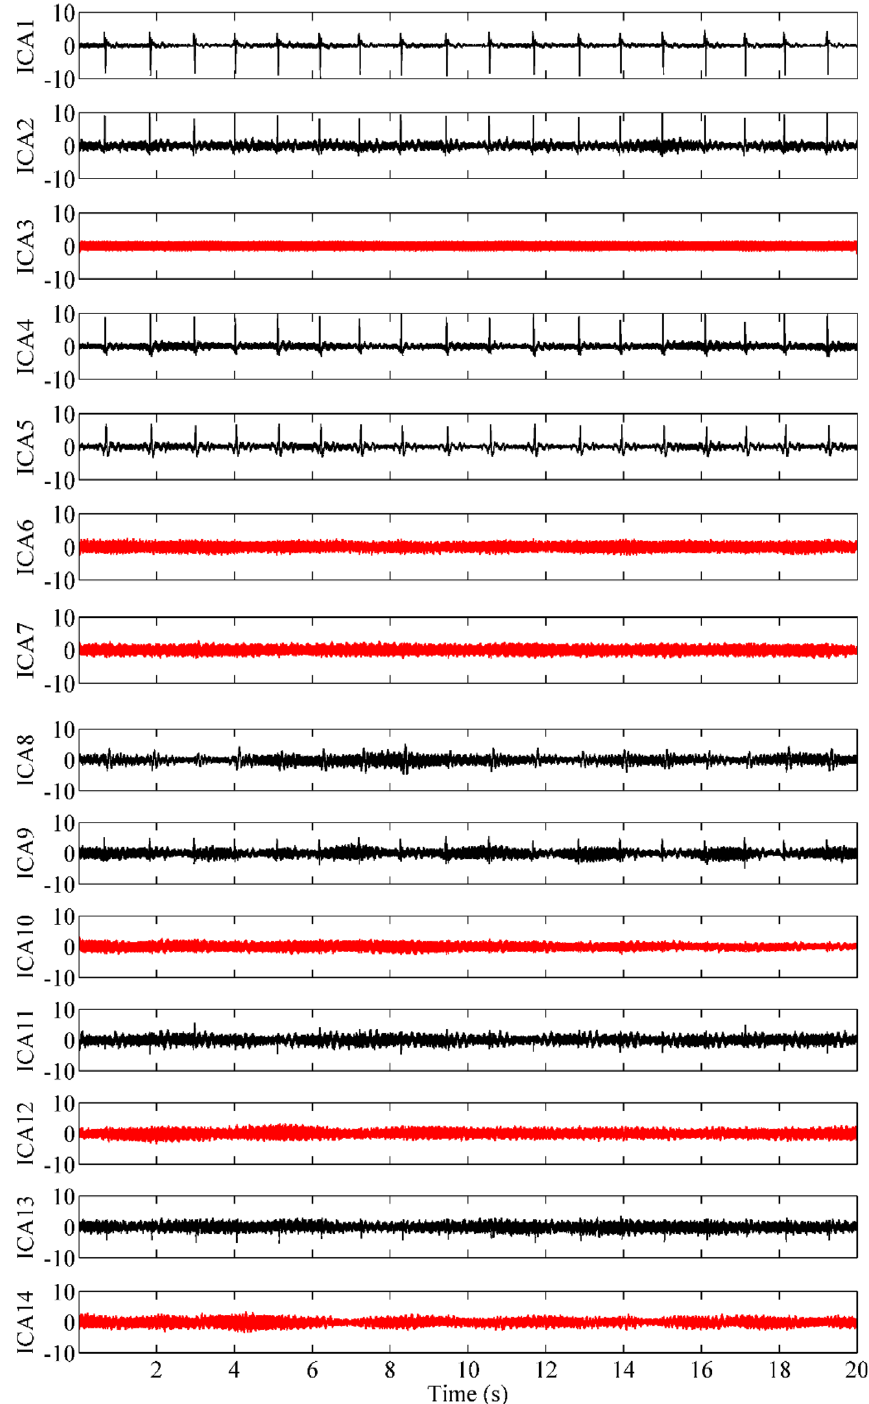
Figure 4. The ICs obtained from the ICA for the MCG data. Artifact components for visual recognition (50 Hz and harmonics) are represented in red, and nonartifact components (guided by cardiac periodic features such as QRS and T waves) are represented in